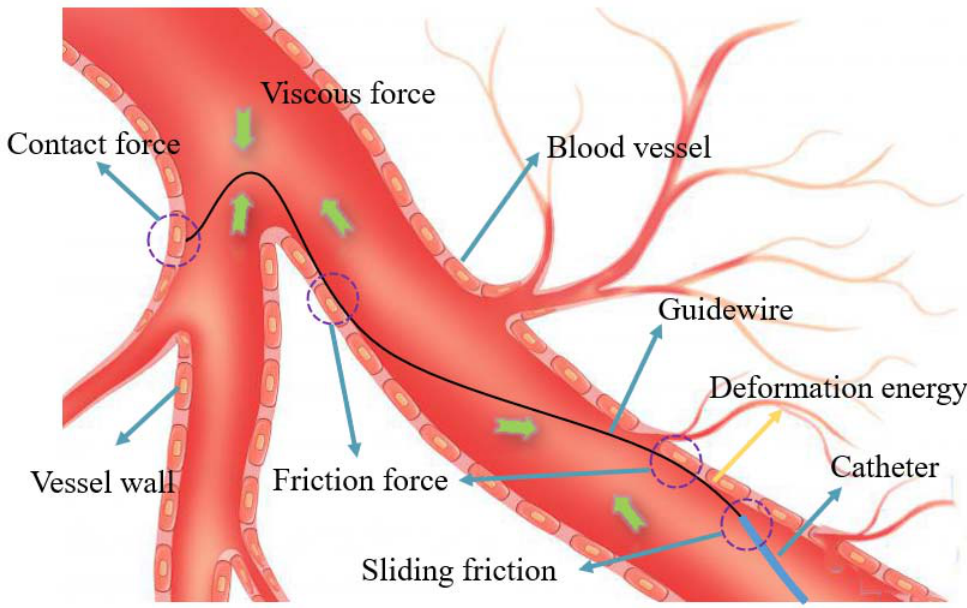
Figure 10. Detection force analysis of the catheter and guidewire.